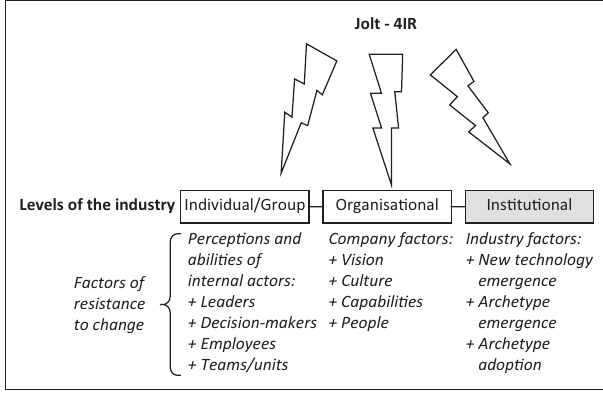
FIGURE 1: Representation of change introduced by the Fourth Industrial Revolution on the insurance industry.